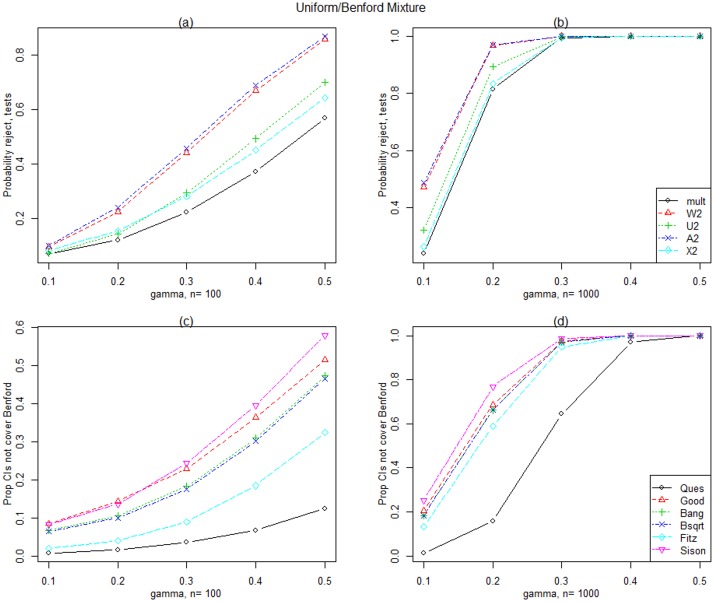
Uniform/Benford mixture distribution results.Simulated power for the tests and simultaneous confidence intervals when data are generated from the Uniform/Benford mixture distribution with various values of γ and for two sample sizes.